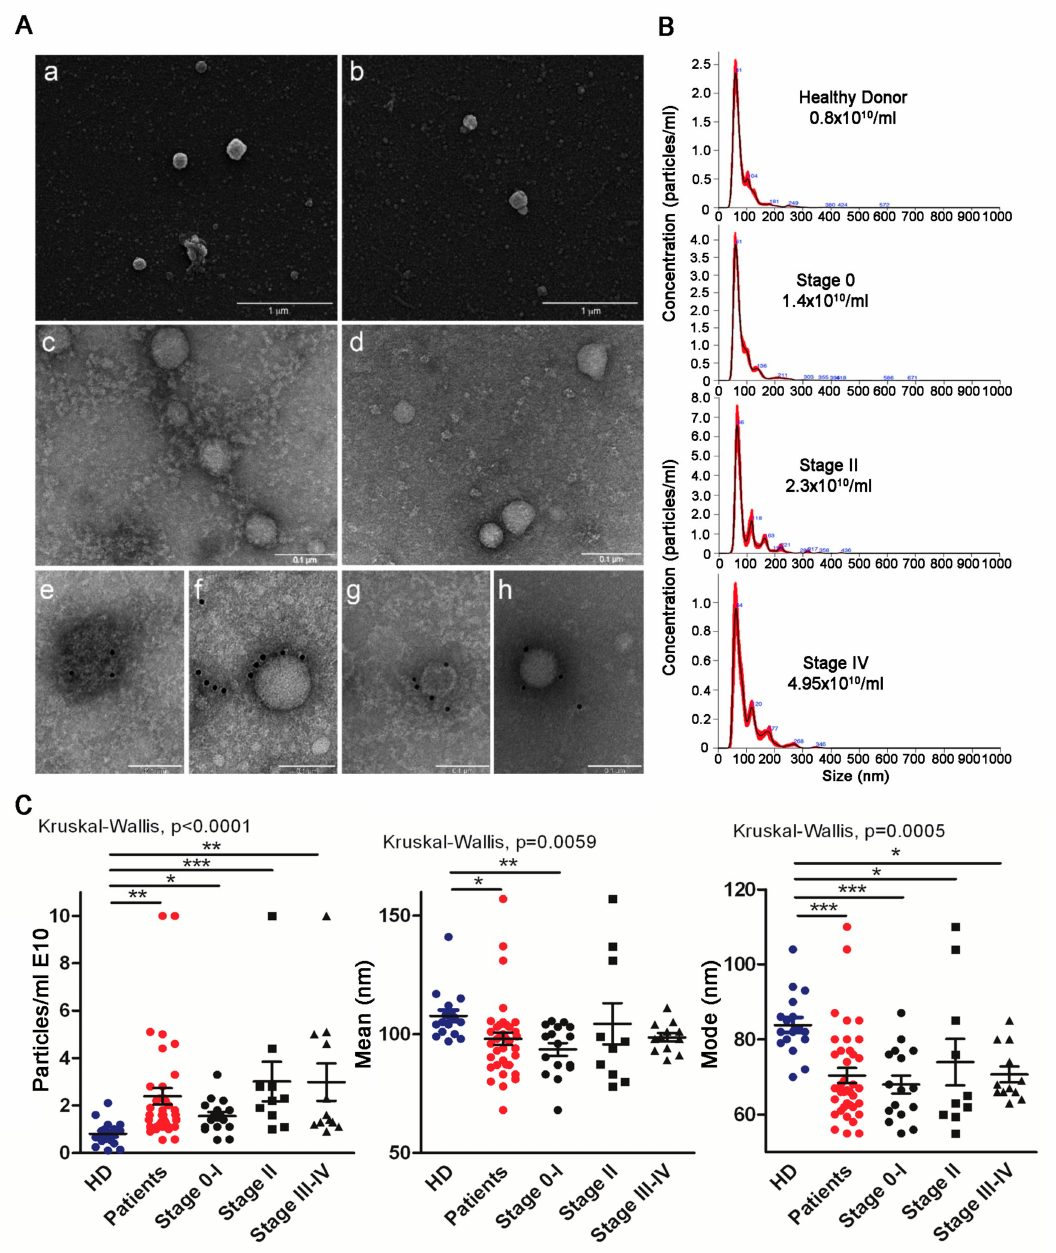
Figure 1. Morphology and nanoparticle tracking analysis (NTA) of total sEV. ( A ) Scanning electron microscopy analysis of total sEV from a HD ( a ), and from a stage II melanoma patient ( b ); bars, 1 µ m. Transmission electron microscopy analysis of HD sEV ( c ) and stage II patients’ sEV ( d ); bars, 0.1 µ m. ( e – h ) Immunoelectron microscopy combined with positive/negative contrast method: D sEV ( e , f ) and stage II patients’ sEV ( g , h ) showing the presence of CD81 ( e , g ) and tsg101 ( f , h ); bars, 0.1 µ m. ( B ) Representative NTA profiles of HD and melanoma patients’ (stages 0, II, IV) sEVs. ( C ) NTA characterization of total sEV from HD and patients, with different stages of disease (particles/mL, mean and mode); HD n = 17; patients n = 38. Statistical significance was achieved with unpaired t -tests for HD vs. patients and with Kruskal–Wallis and Dunn post-tests for HD vs. stages. * p < 0.05, ** p < 0.001, *** p <